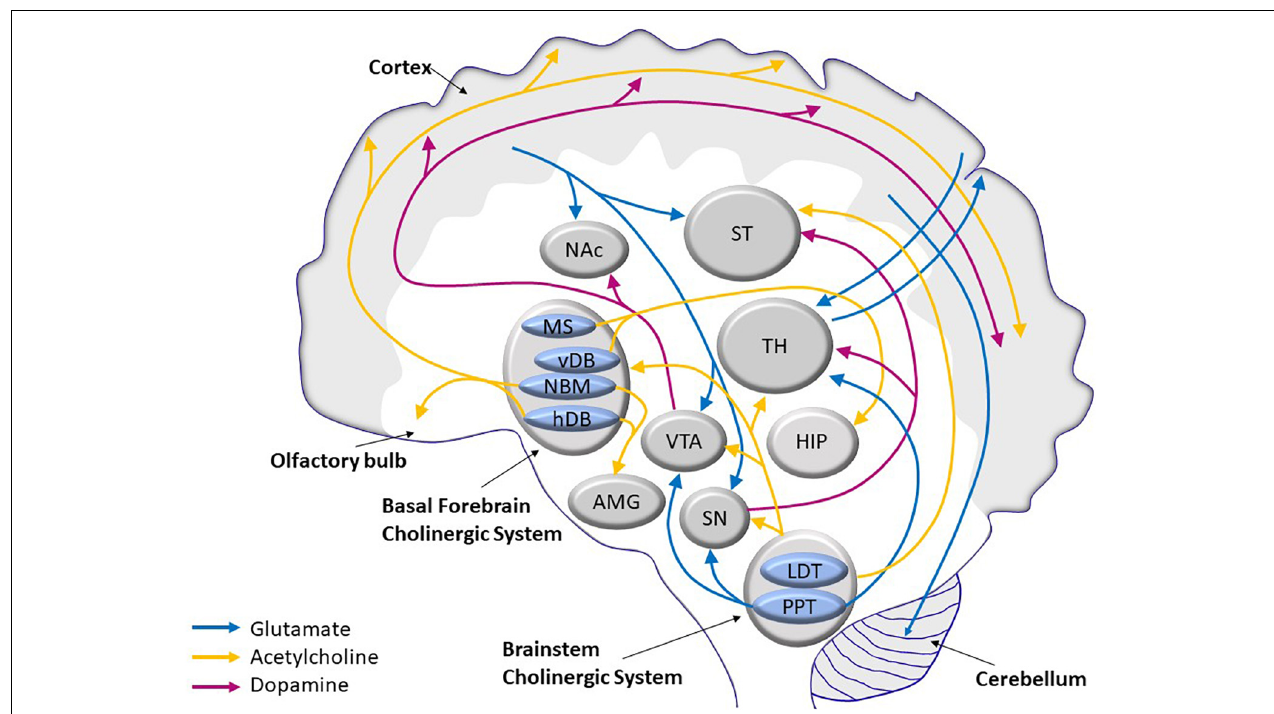
FIGURE 1 | Scheme of the main glutamatergic, cholinergic, and dopaminergic neurocircuits and their convergence in the human brain. AMG, amygdala; HDB, horizontal limb of the diagonal band of Broca; HIP, hippocampus; LDT, laterodorsal tegmental nucleus; MS, medial septum; NAc, nucleus acccumbens; NBM, nucleus basalis of Maynert; PPT, pedunculopontine tegmental nucleus; SN, substantia nigra; ST, striatum; TH, thalamus; VDB, vertical limb of the diagonal band of Broca; VTA, ventral tegmental area.